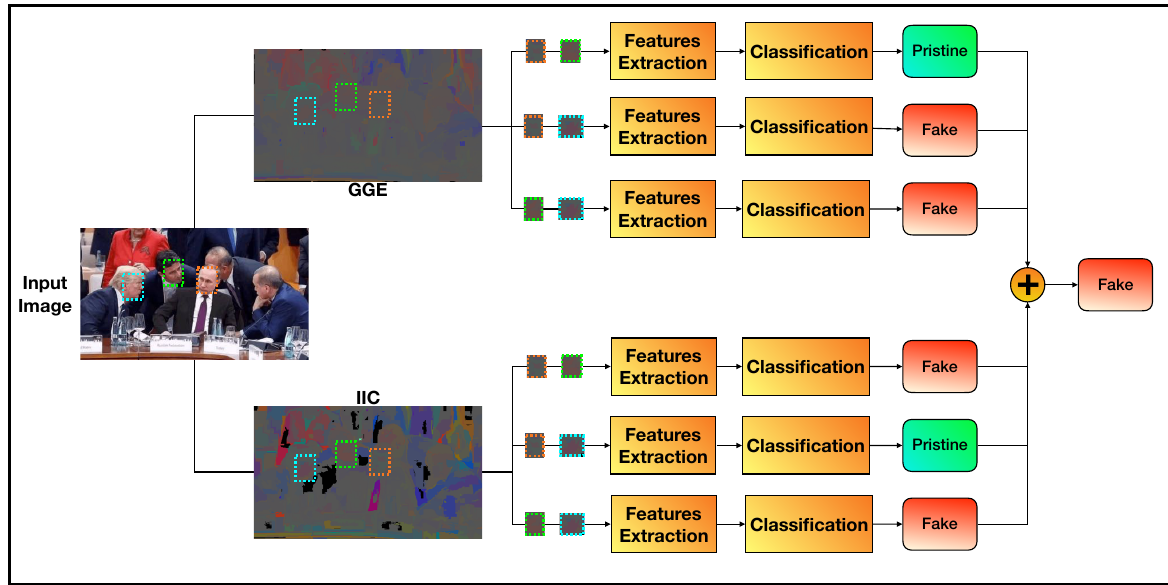
Figure 4 - Overview of the method proposed by Carvalho et al. (2016). An image is analyzed by segmenting all suspected faces. Each face is represented in the transformed illuminant space and further characterized through some image description methods such as the ones involving patterns of texture, color, and shape. Then, the descriptors for all pairs of faces in the image are concatenated. Ultimately, a classifier is trained based on the concatenated feature vectors to issue an authenticity decision upon receiving each pair of